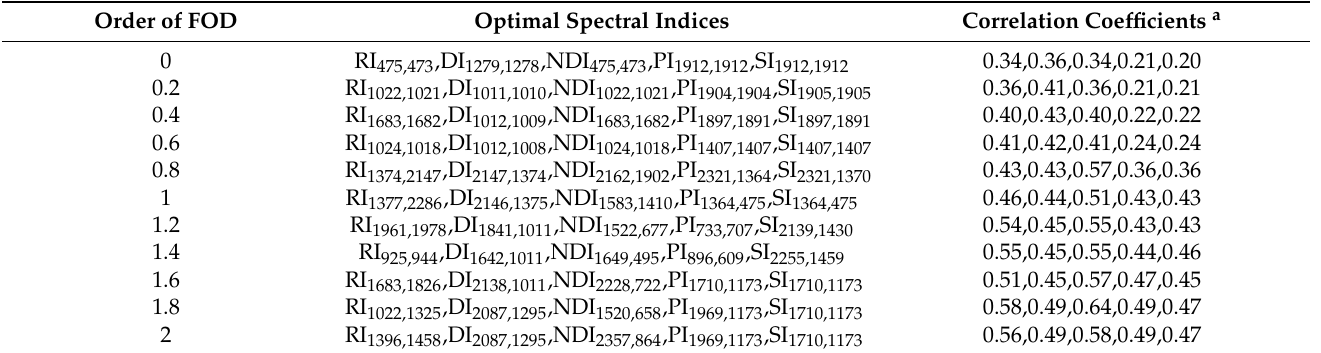
Table 2. The bands and correlation coefficient of optimal spectral indices for Hg.